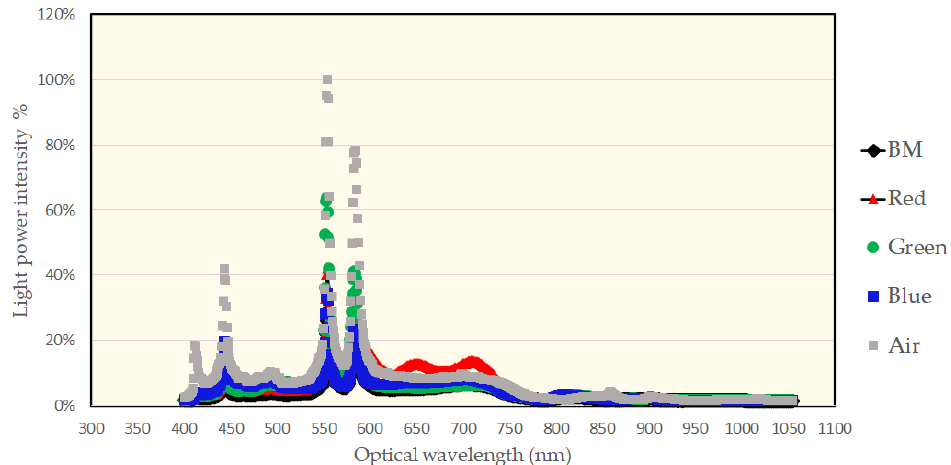
Figure 7. The distribution of the spectrum measures of the photoresists for the black matrix (BM),